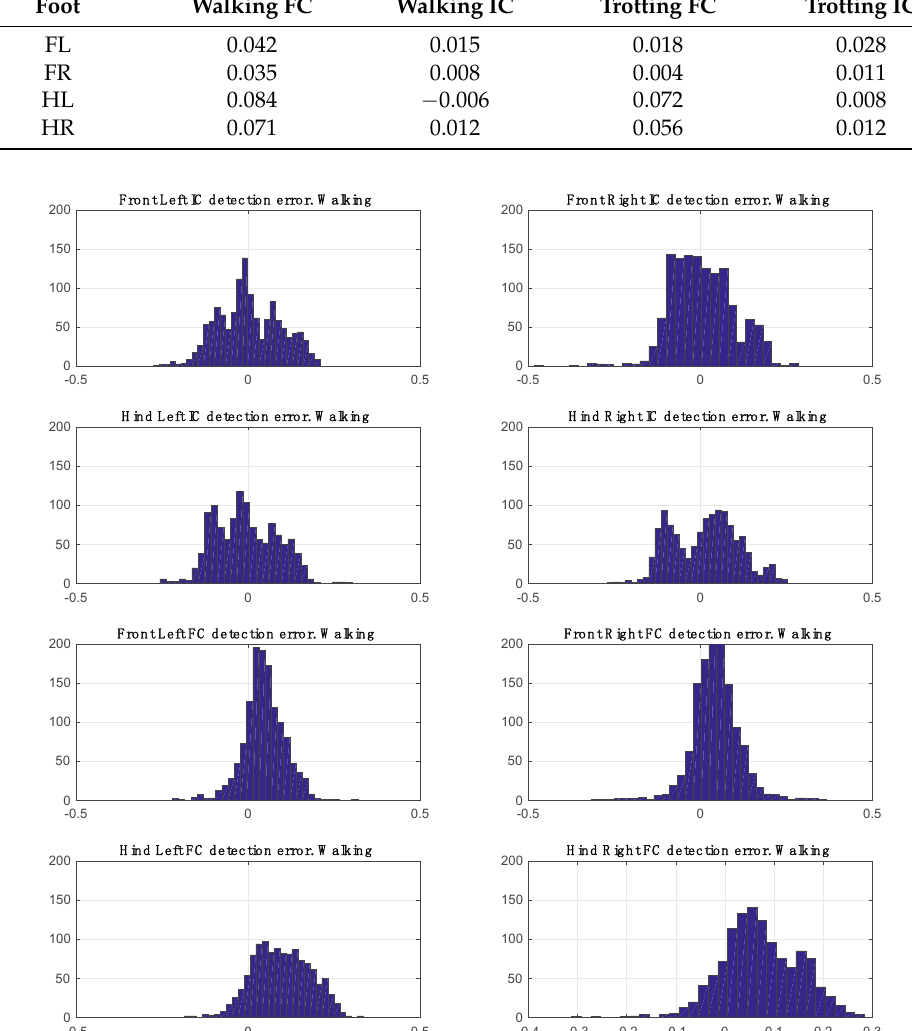
Figure 9. Disagreement between predictions and annotations during walking.